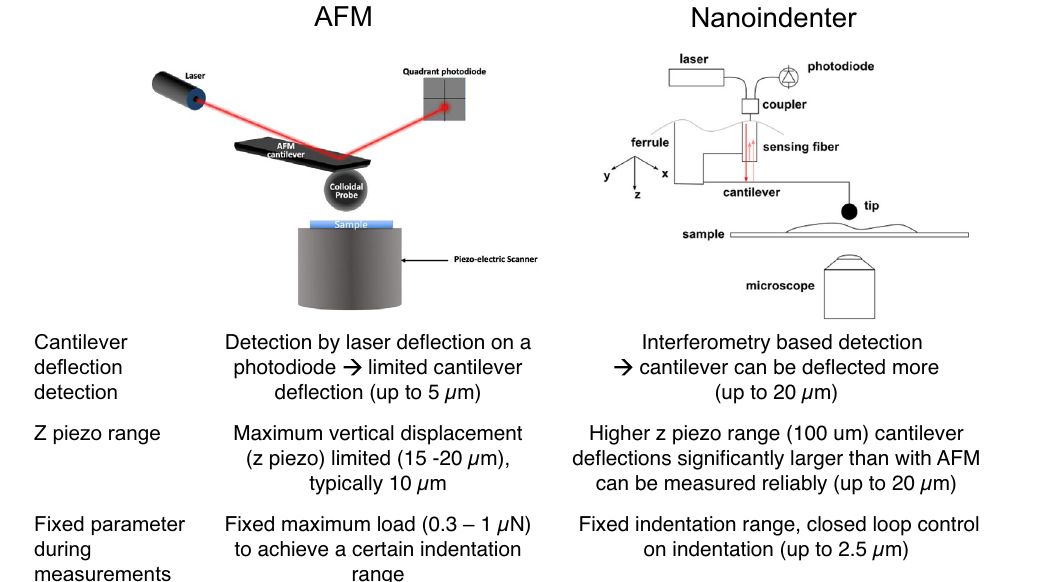
Fig. 7 Indentation techniques. AFM (left) and Chiaro nanoindenter (right). The main difference between both indentation instruments are the z piezo range, the detection of cantilever de fl ection and the fi xed parameter during